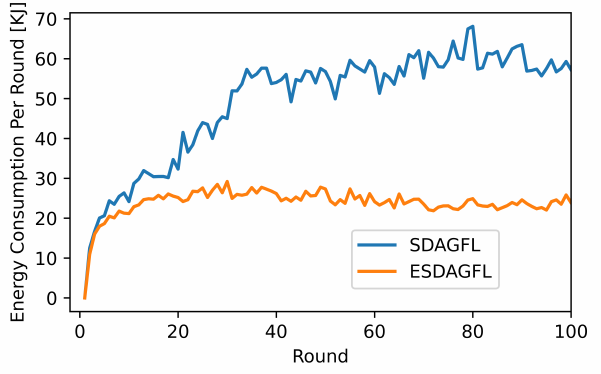
Figure 11. Energy consumption in every round evaluated on the Poets dataset.